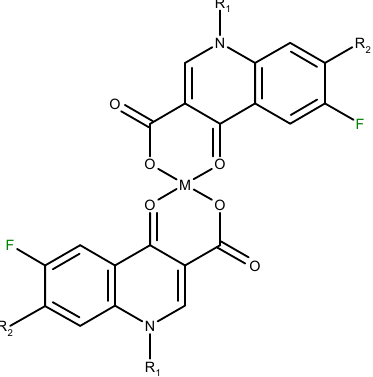
Figure 5. The general structure of 1:2 (metal:ligand) quinolone chelates with divalent